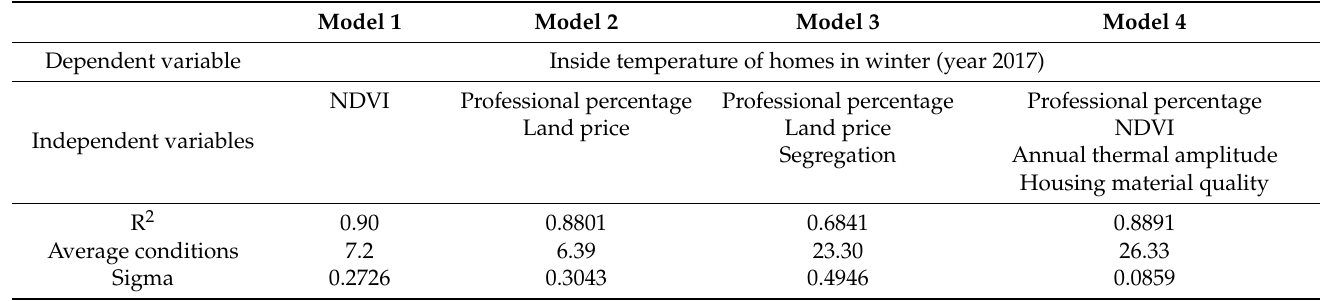
Table 2. Description of the selected GWR models and their statistical